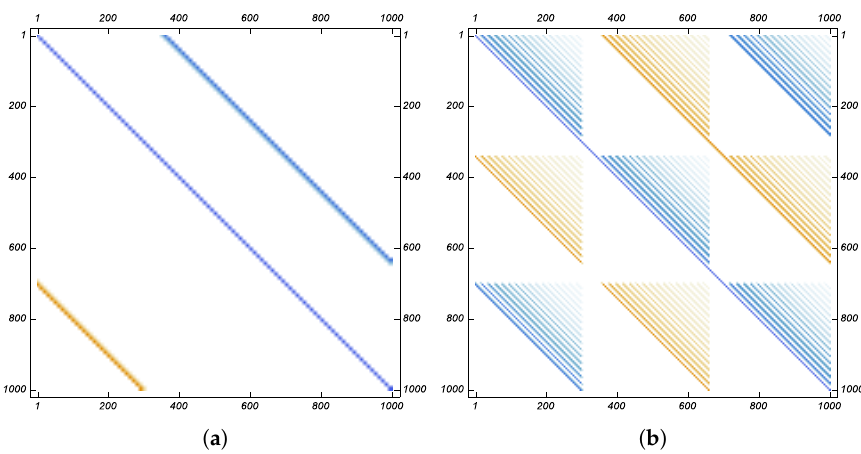
Figure 1. Representation of the ( a ) matrix and ( b ) inverse matrix for Example